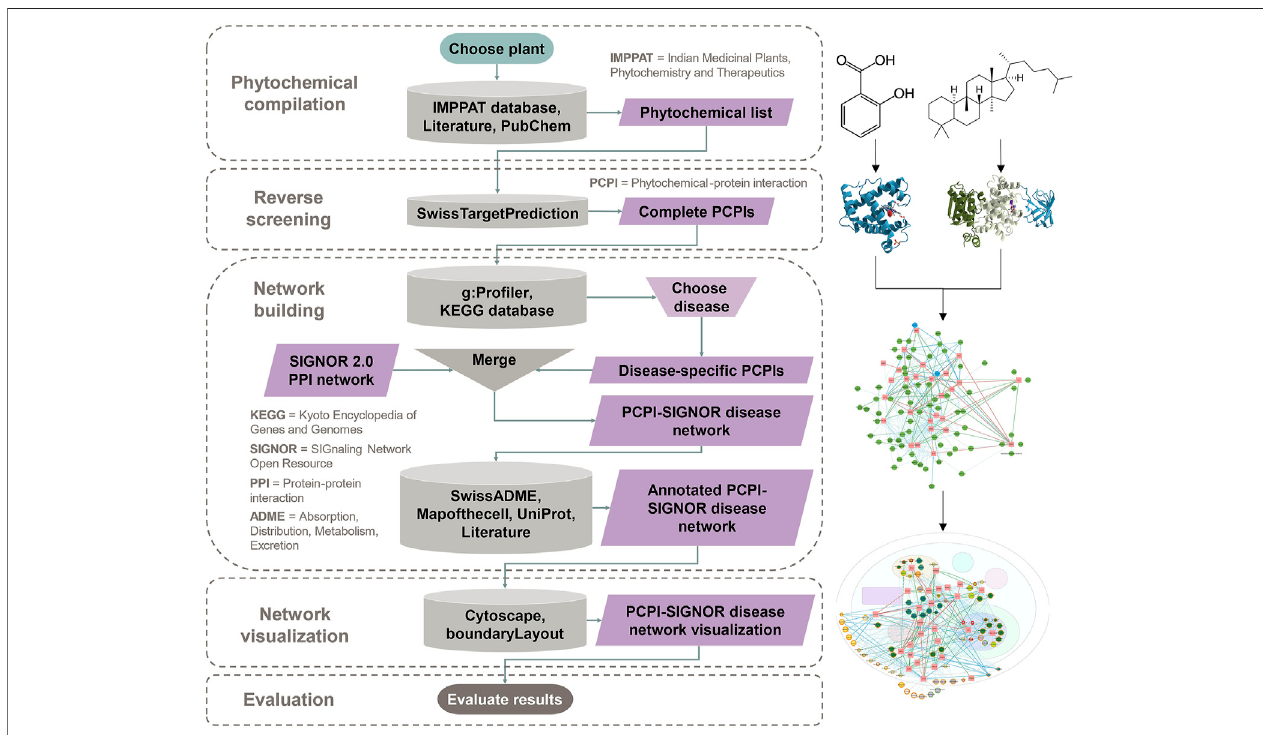
FIGURE 1 | The work fl ow begins with phytochemical compilation for the chosen plant. This is followed by reverse screening to predict PCPIs. Network building fi ltersPCPIstothechosendisease,combinesthesewithPPIs,andannotatesthenetworkwithphytochemicalandproteinattributes.Theannotatednetworkisvisualized with Cytoscape. Evaluation is done through any in silico , in vitro , or in vivo method. This fl owchart and links to resources can be found at https://yumibriones.github.io/ network/work fl